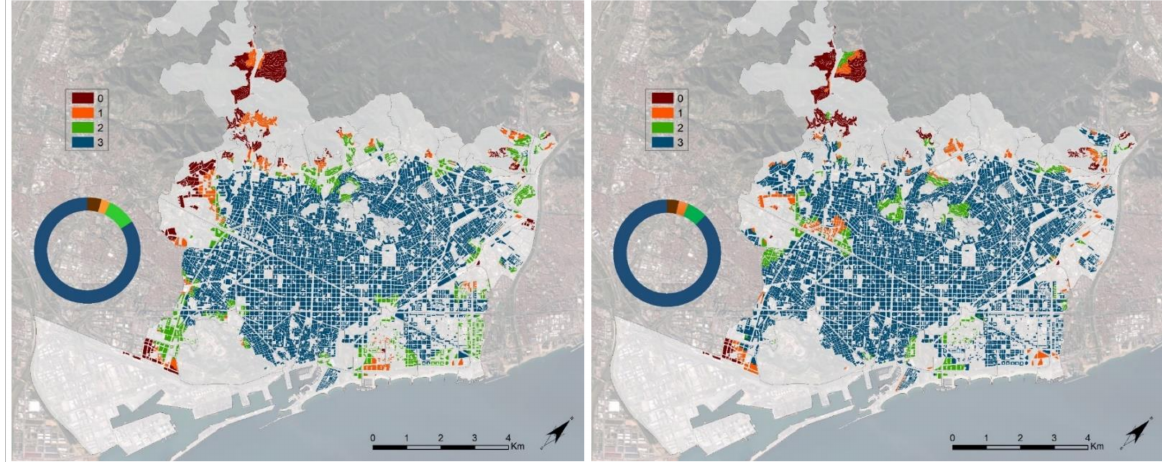
Figure 4. Care features (left side) and education (right side). Number of variables accessible simulta- neously from each of the parcels. Source: own elaboration based on data from Open Data BCN [42] and the 1: 5000 Orthophoto from ICGC, used under a CC BY 4.0 license